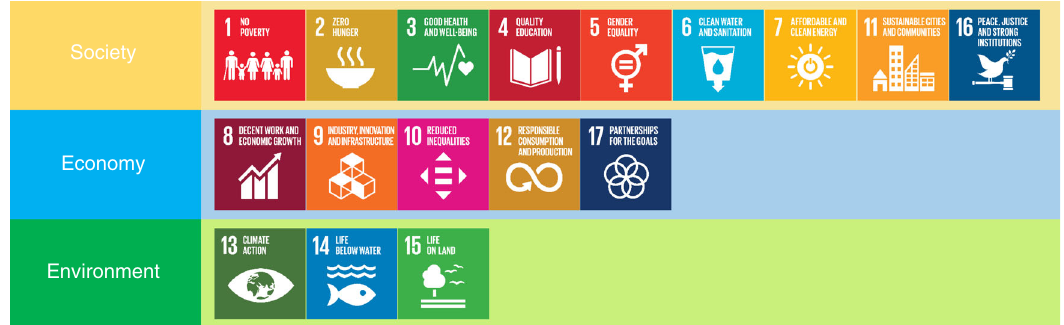
Fig. 6 Categorization of the SDGs (https://www.un.org/sustainabledevelopment/) into the Society, Economy, and Environment groups. (The content of this fi gure has not been reviewed by the United Nations and does not re fl ect its